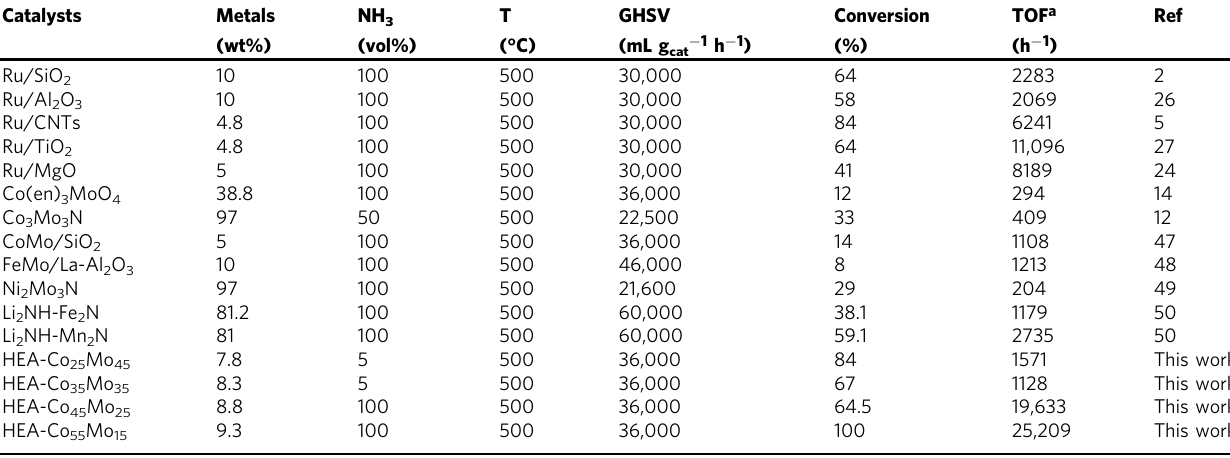
Table 2 Comparison of the catalytic performance for NH 3 decomposition of different catalysts Catalysts Metals Ru/SiO